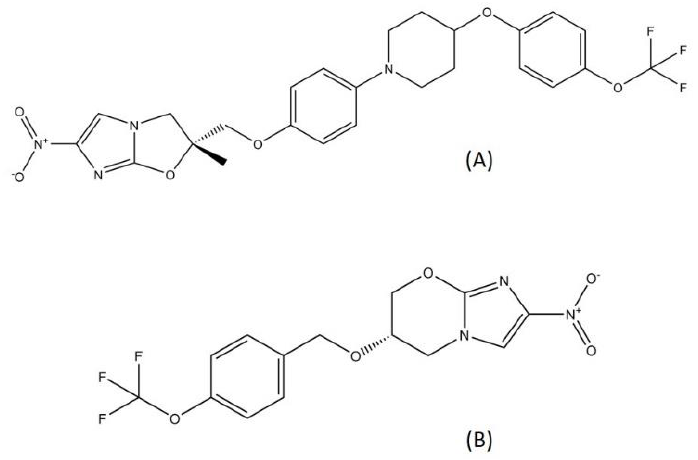
Figure 5. Structure of ( A ) delamanid and ( B ) pretomanid.